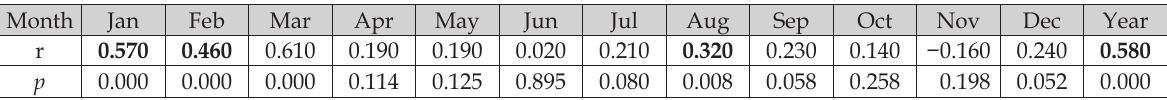
Table 3. Values of correlation coefficients (r) and their statistical significance ( p ) between (DJFM) winter NAO Hurrell index and monthly and annual air temperature in Wrocław (1951–2018).